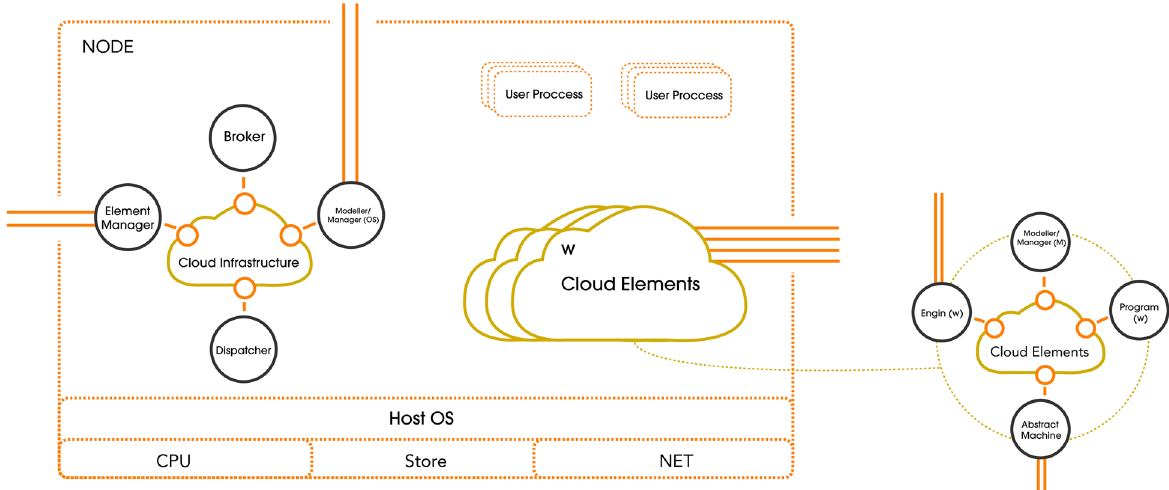
Fig. 1 An illustration for the proposed designed nodes’ components between the cloud infrastructure and cloud elements that was proposed in [24]